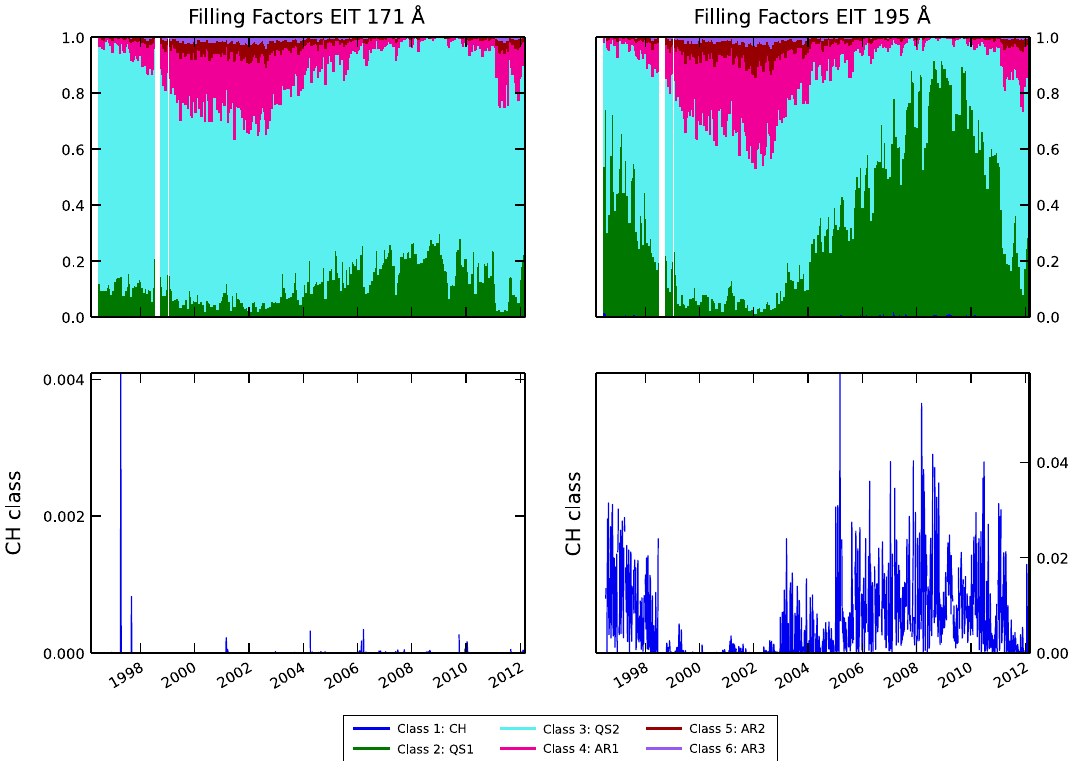
Fig. 5. Area coverages for the six classes spanning the period March 1996–December 2012 for the EIT 171 Å bandpass (top left panel) and the EIT 195 Å bandpass (top right panel). The extent on the y -axis gives the area coverage for the corresponding class, with the six features summing to one. The classes are displayed from bottom to top in order of increased intensity values, from the coronal holes (Class 1, CH) up to the brightest part of an active region (Class 6, AR3). The bottom panels show a zoom-in of the area coverage of the coronal holes. The data gaps in the EIT and SEM data are due to the SOHO vacation in summer and fall of 1998.